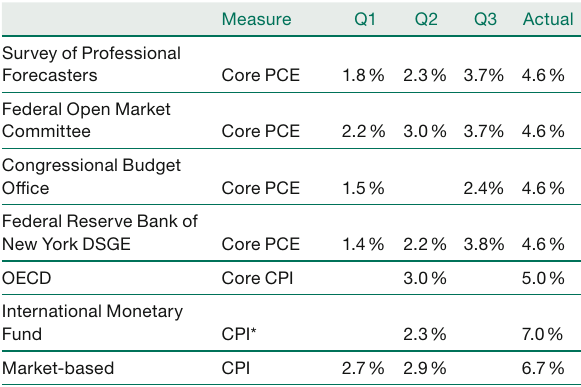
2021 (Q4/Q4) infl ation forecasts Estimated eff ect of December 2020 and March 2021 fi scal stimulus on real